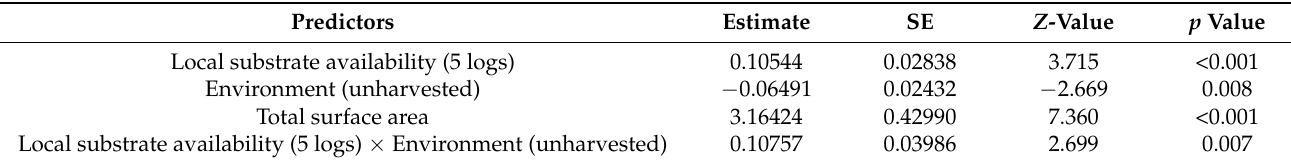
Table 1. Best generalised linear mixed model selected to predict the total number of beetles found in a log. Model estimates for categorical predictors are those for the condition represented in